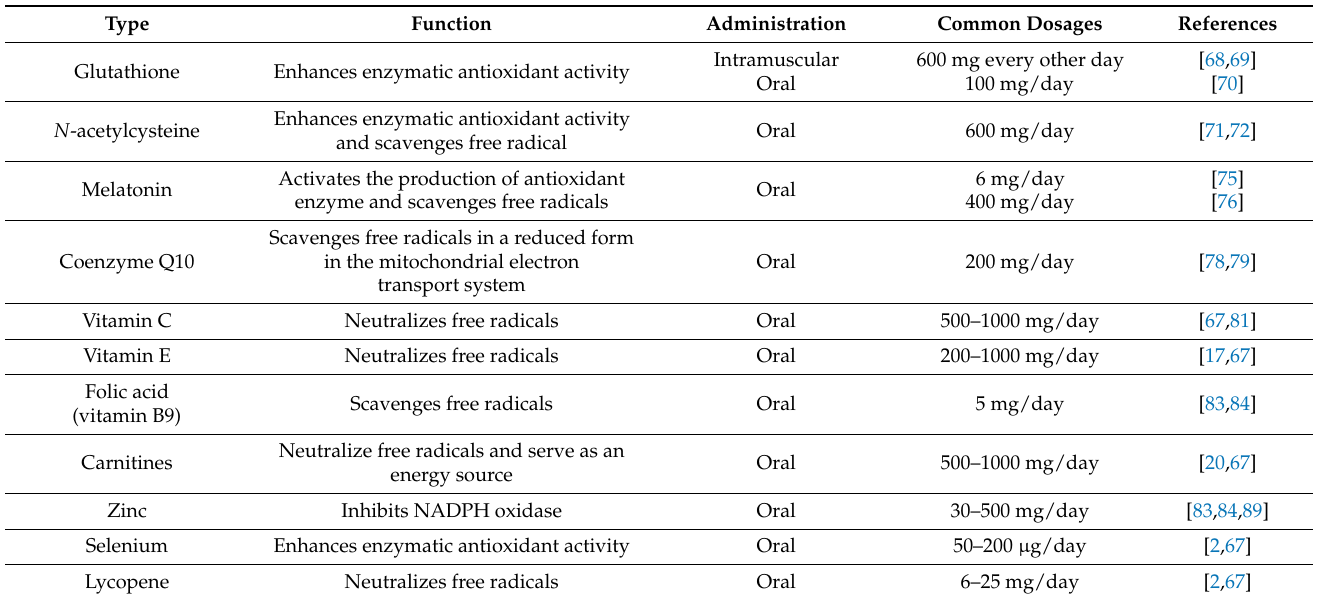
Table 1. Application of non-enzymatic antioxidants in the treatment of male